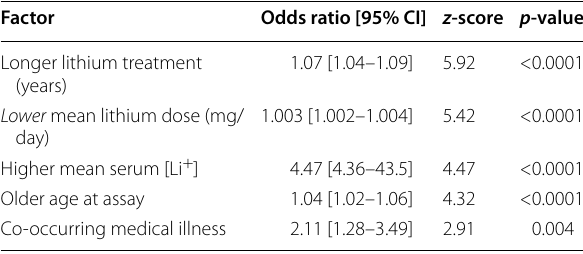
Table 8 Multivariate logistic regression model for factors associated with low eGFR (<60 mL/min/1.73 m 2 )